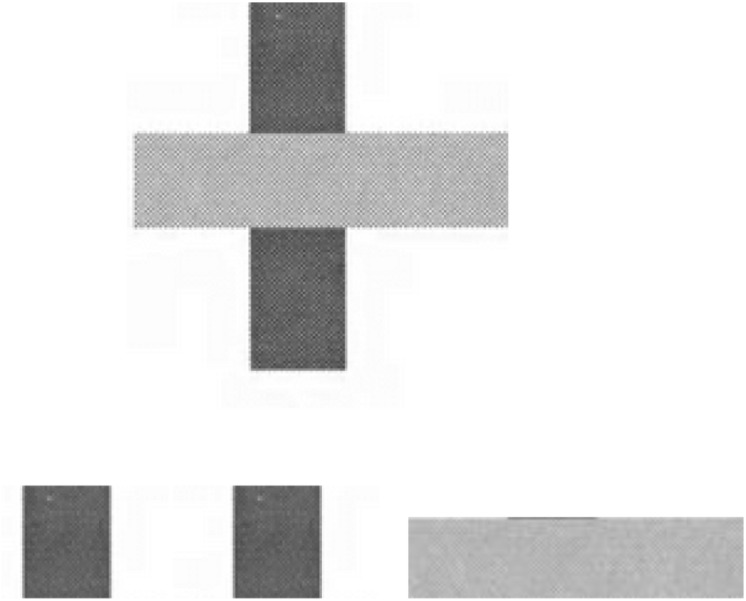
Figural occlusion.